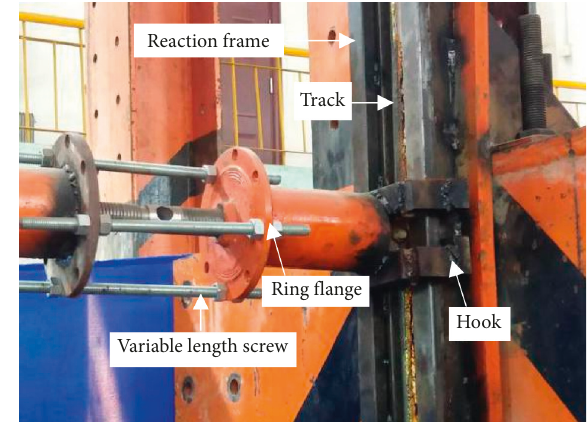
Figure 6: Details of three directional constraints.